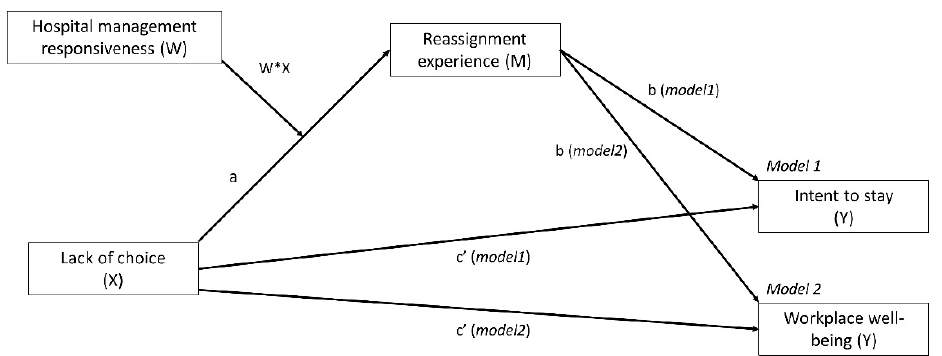
Figure 1. Moderated meditation models for intent to stay (model 1) and workplace well-being (model 2). Note: X is the predicting variable, Y is the outcome variable, M is the mediator, W is the moderator, and W * X is the interaction between the predicting variable and the moderator; a, b, and c’ are paths in the model.